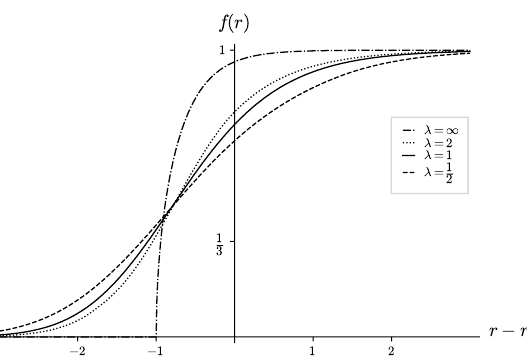
Figure 6 . The asymptotic profiles of the scalar field f ( r ) obtained by numerical solution of the boundary layer equations for different values of scalar self-coupling and the analytic result eq. (2.36) for λ → ∞ as functions of r − r n . For λ → 0 the scalar field vanishes throughout the boundary layer as λ 1 / 4